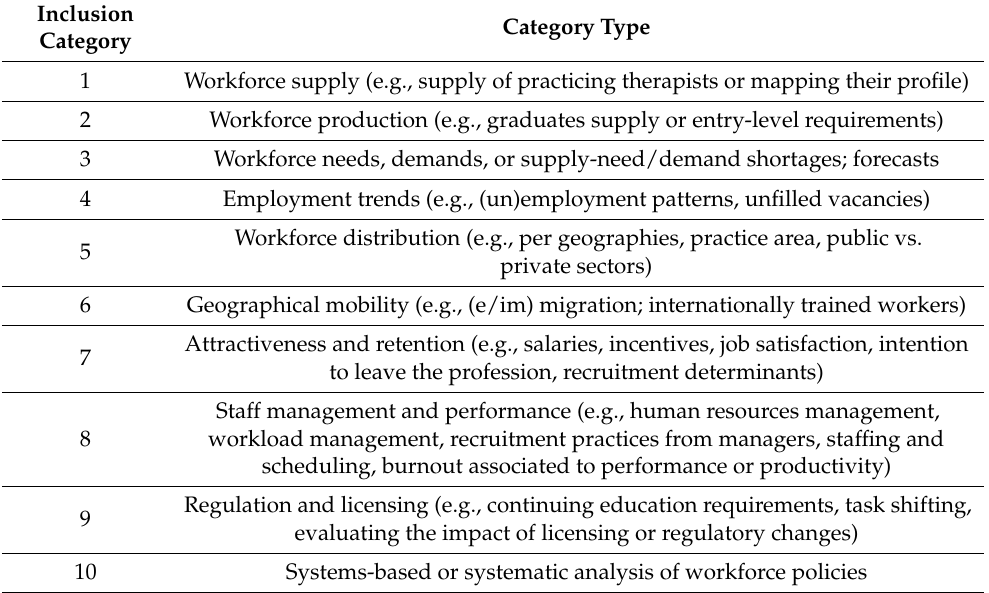
Table 1. Inclusion categories for the major topics of workforce research included, synthesized from the review